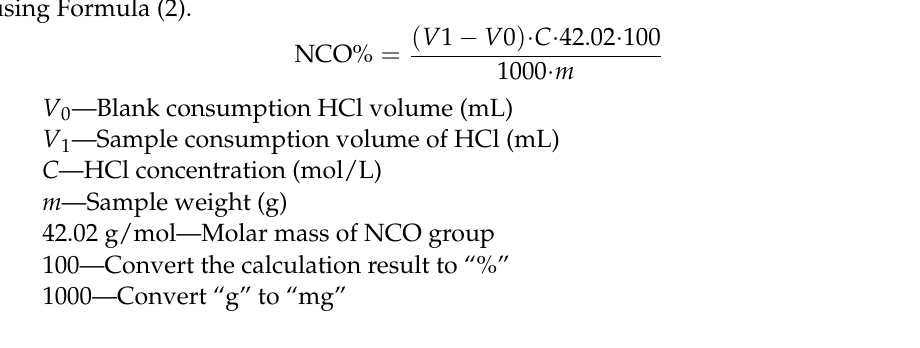
Table 3. Characteristics of PU.